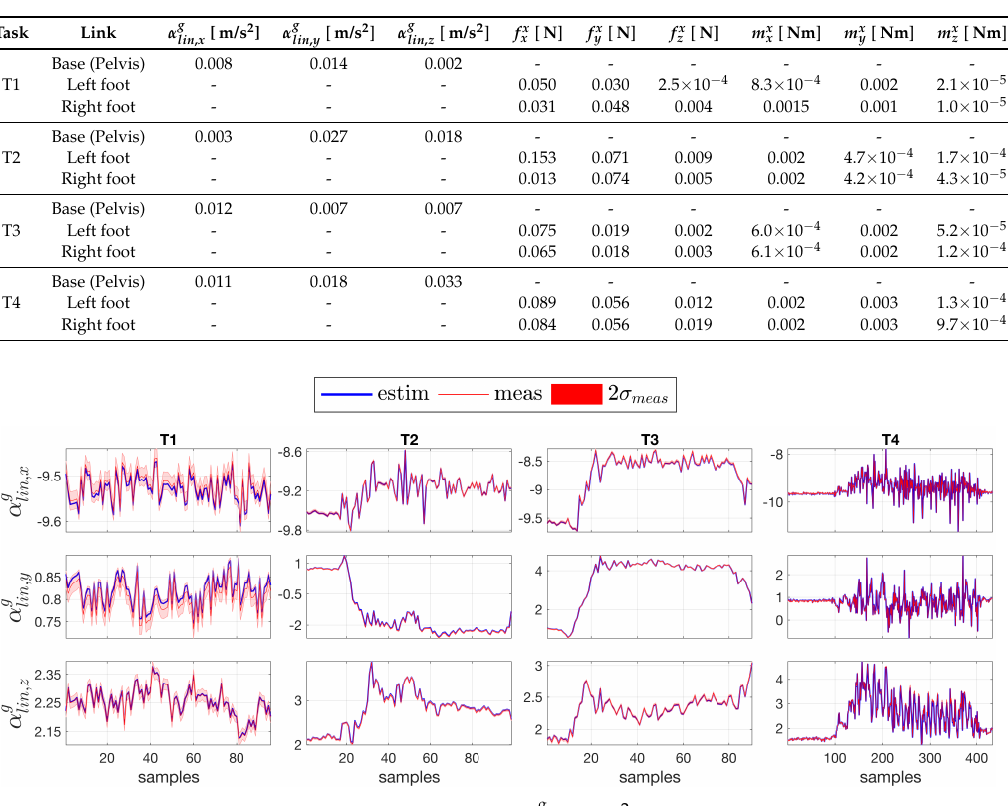
[ m/s 2 ] comparison between measurement lin